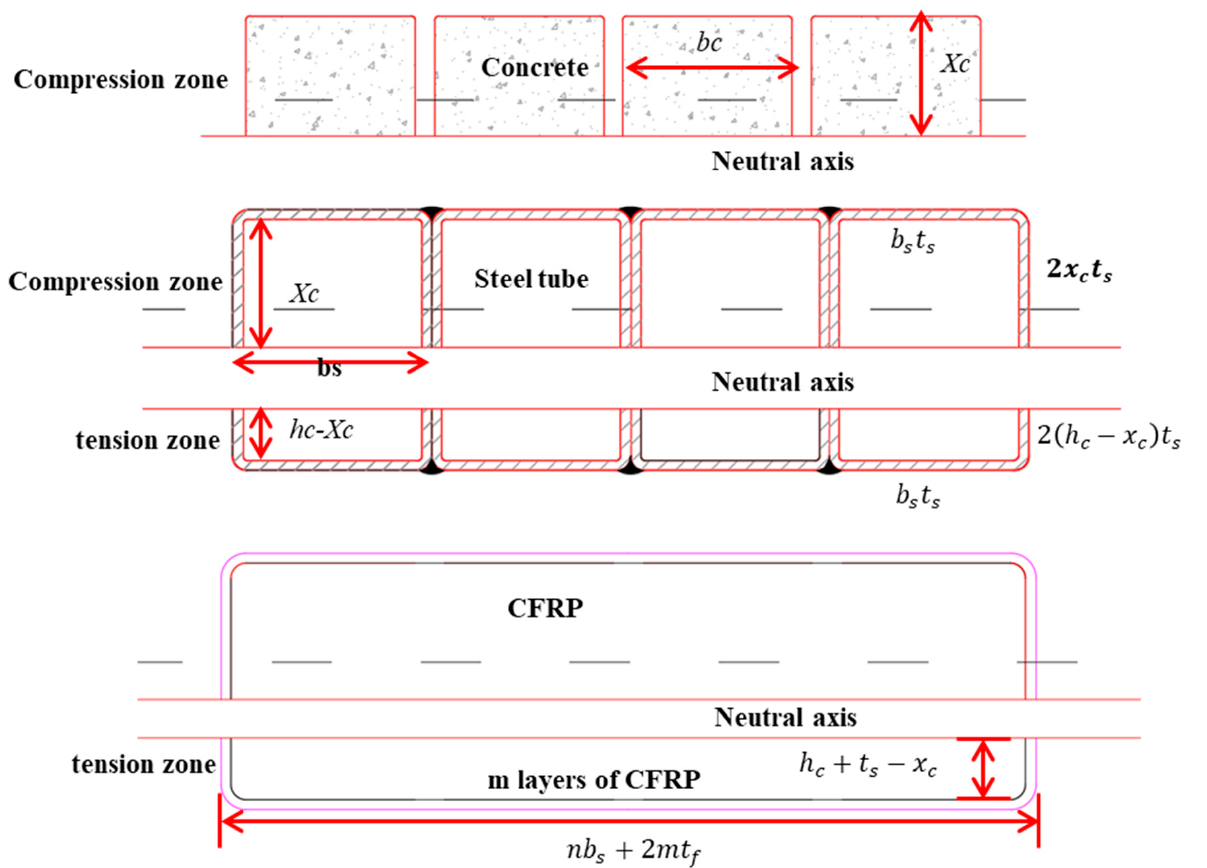
Figure 14. Cross-section of FWP under bending